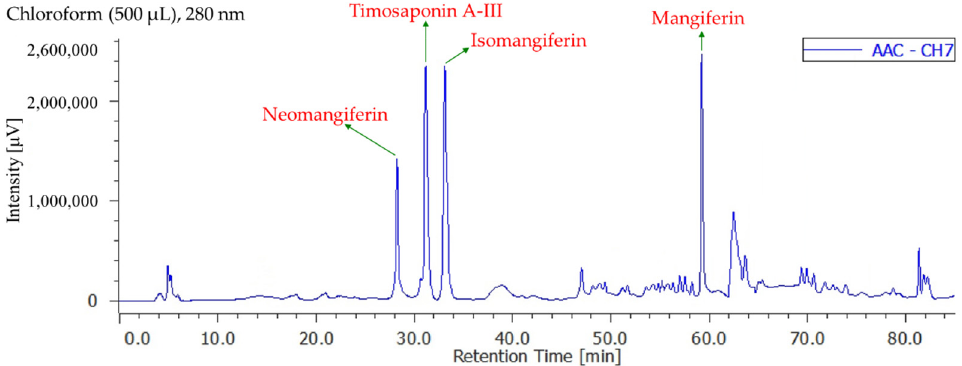
Figure 2. Reverse-phase HPLC chromatogram of chloroform extract in non-salt-fried rhizomes of A. asphodeloides .